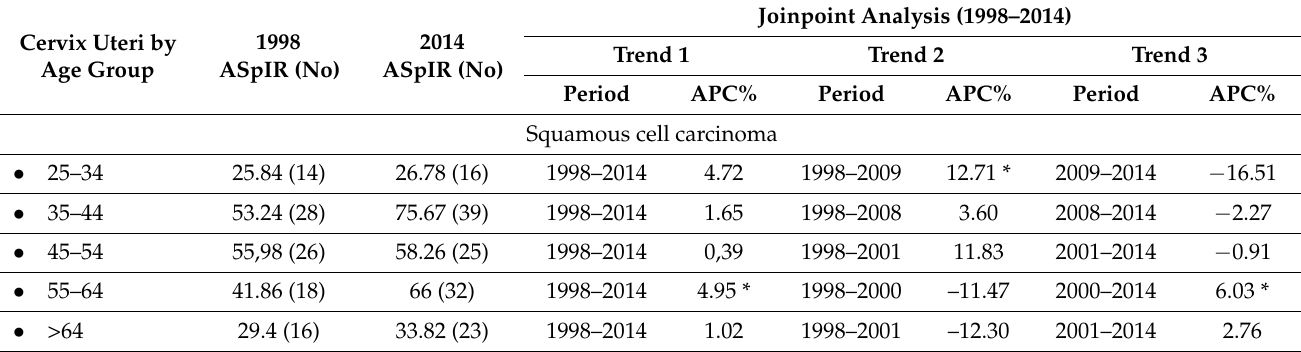
Table 4. Time trends of the age-specific incidence rates (ASpIR) (cases/100,000), by pathological type, 1998–2014.